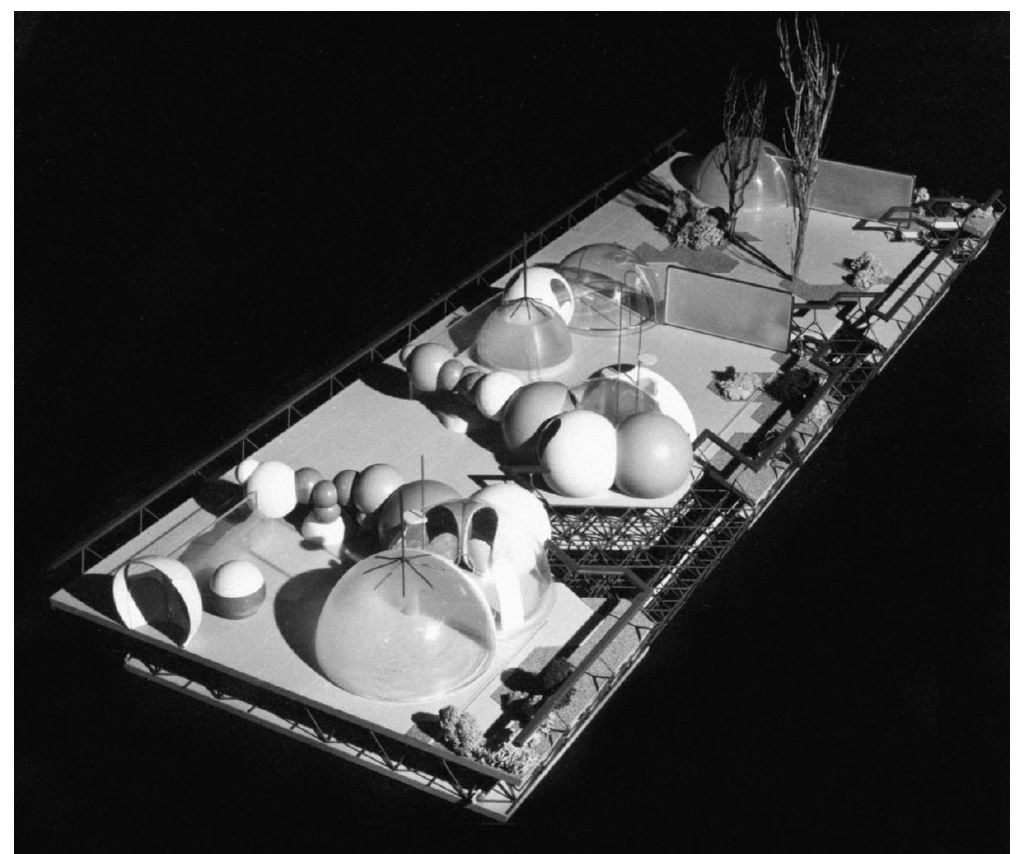
Figure 2. Takis Ch. Zenetos, physical model for “Electronic Urbanism.” Part of a level, 1971. Image courtesy of the Takis Ch. Zenetos Archive.